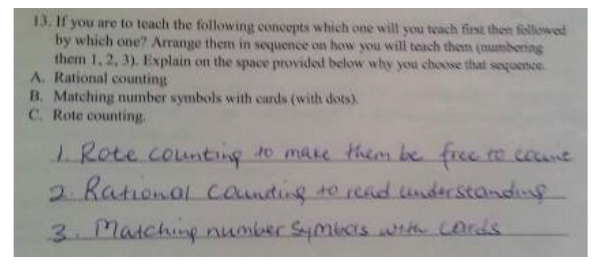
FIGURE 13: Response showing sensible ordering of concepts.